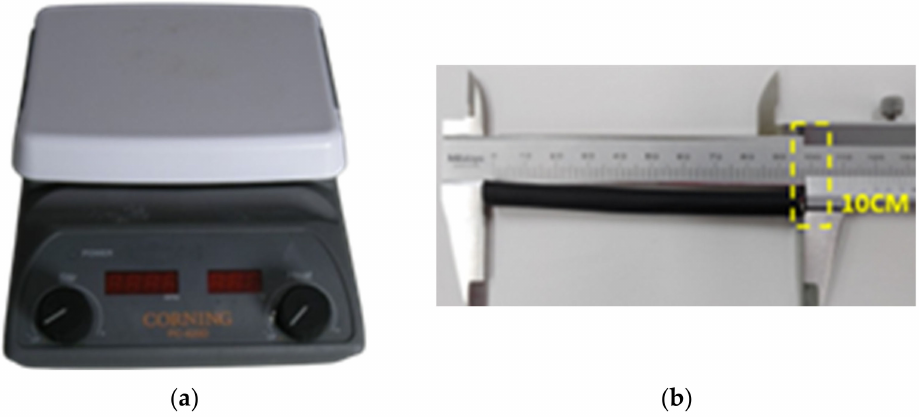
Figure 7. Experiment environment. ( a ) Hot plate, ( b ) UL 2464